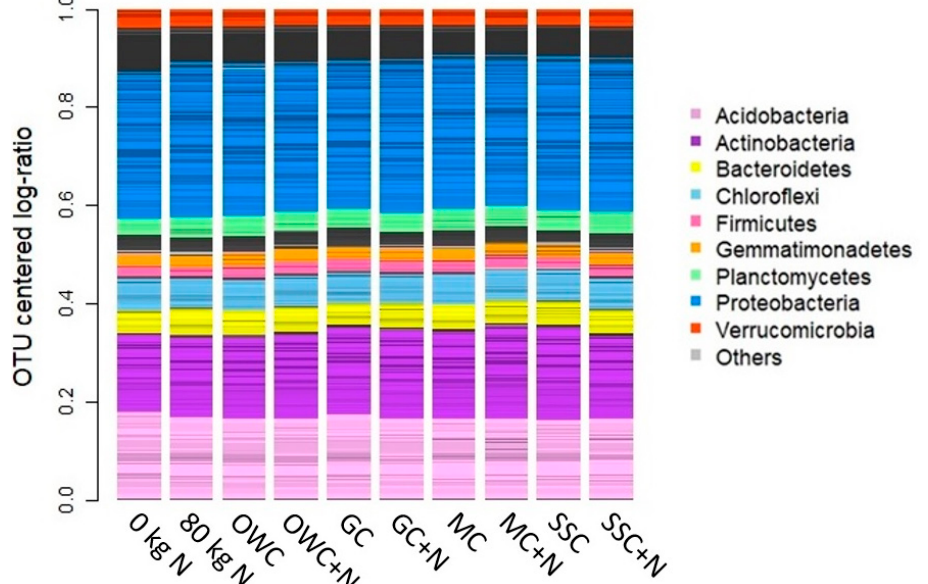
Figure 5. Overview of the taxonomic composition of bacteria in the different treatments. Control (0 kg N), 80 kg mineral N ha − 1 (80 kg N), 175 kg N ha − 1 of composts, urban organic waste compost (OWC), green waste compost (GC), farm yard manure compost (MC), sewage sludge compost (SSC), + N application of 80 kg N ha − 1 .